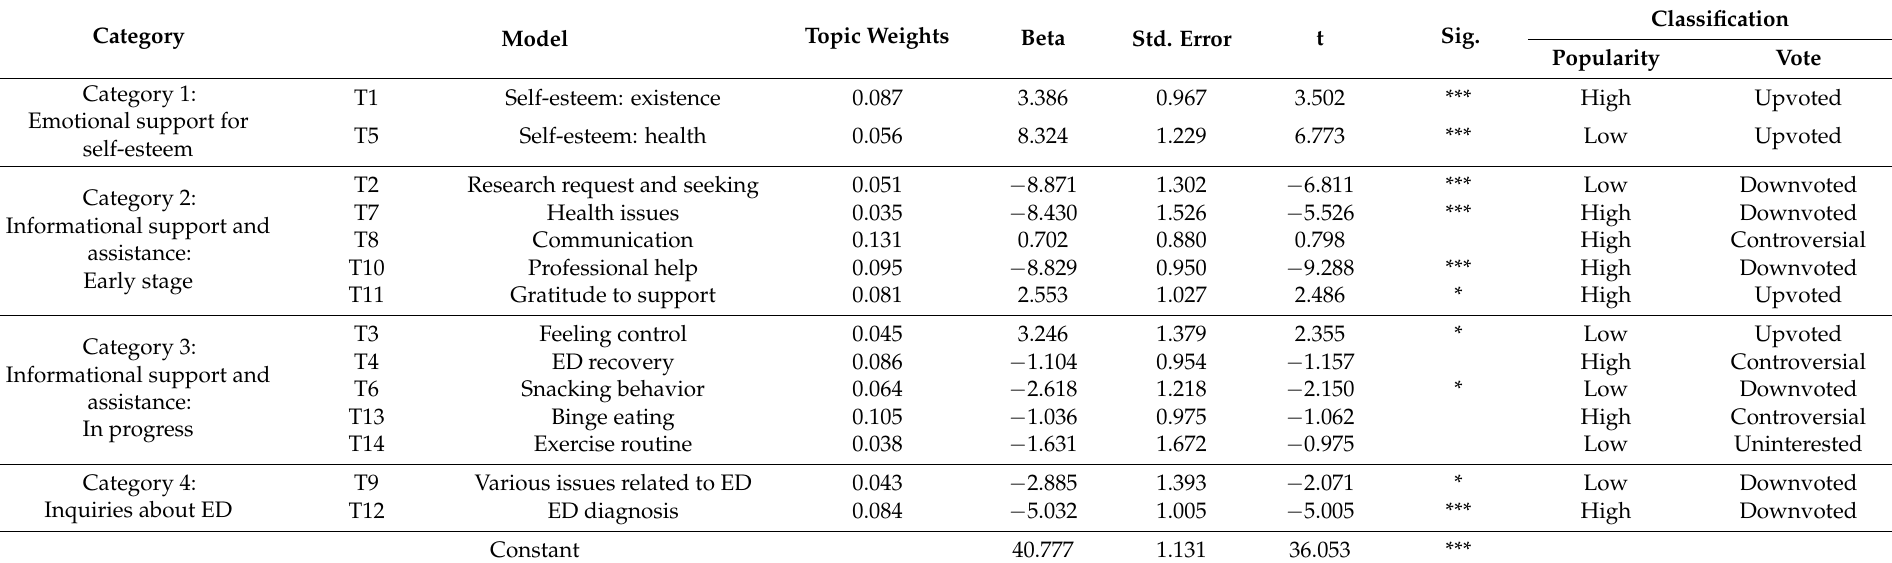
Table 3. Regression